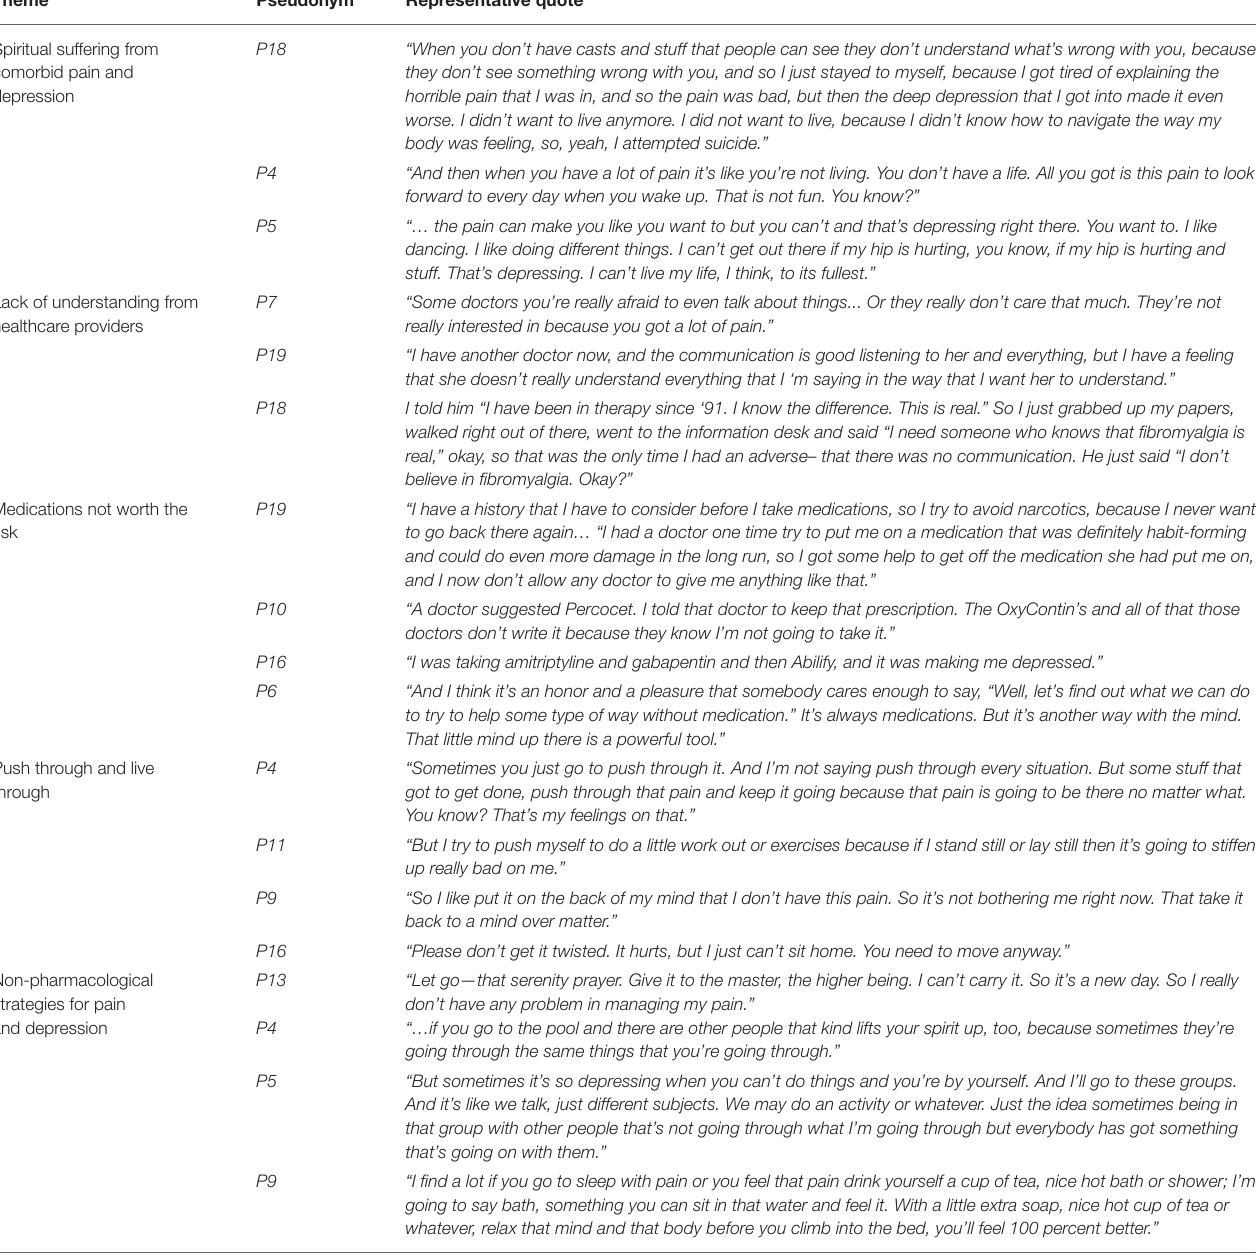
TABLE 2 | Representative excerpts from the focus groups. Theme Pseudonym Representative quote Spiritual suffering from comorbid pain